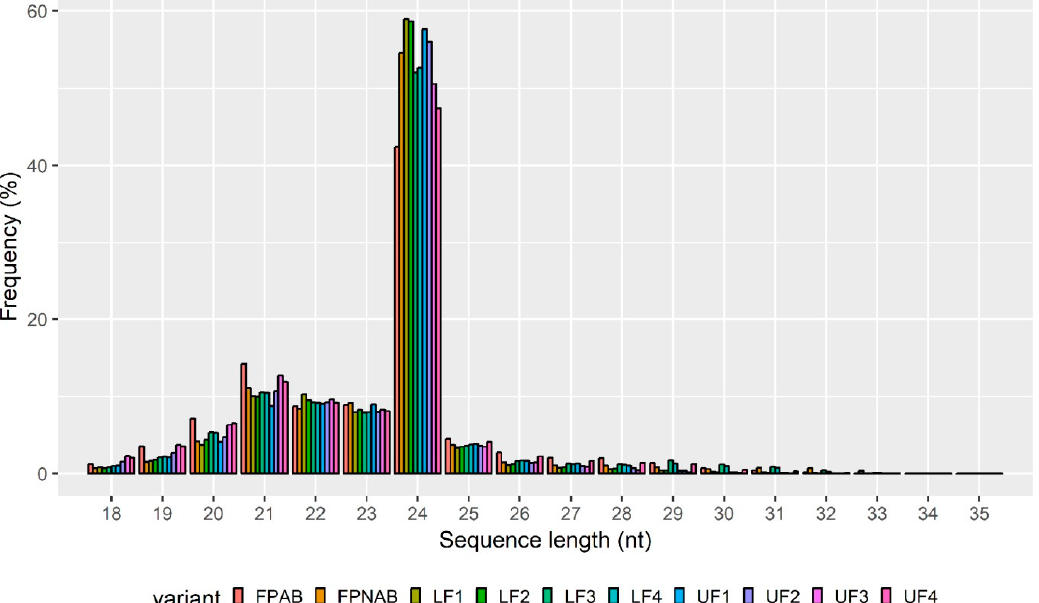
Figure 2. Nucleotide length distribution of small RNAs from all ten libraries: Y -axis represents the percentage frequency of the sRNA sequences identified in this study, the X -axis represents sRNA length.